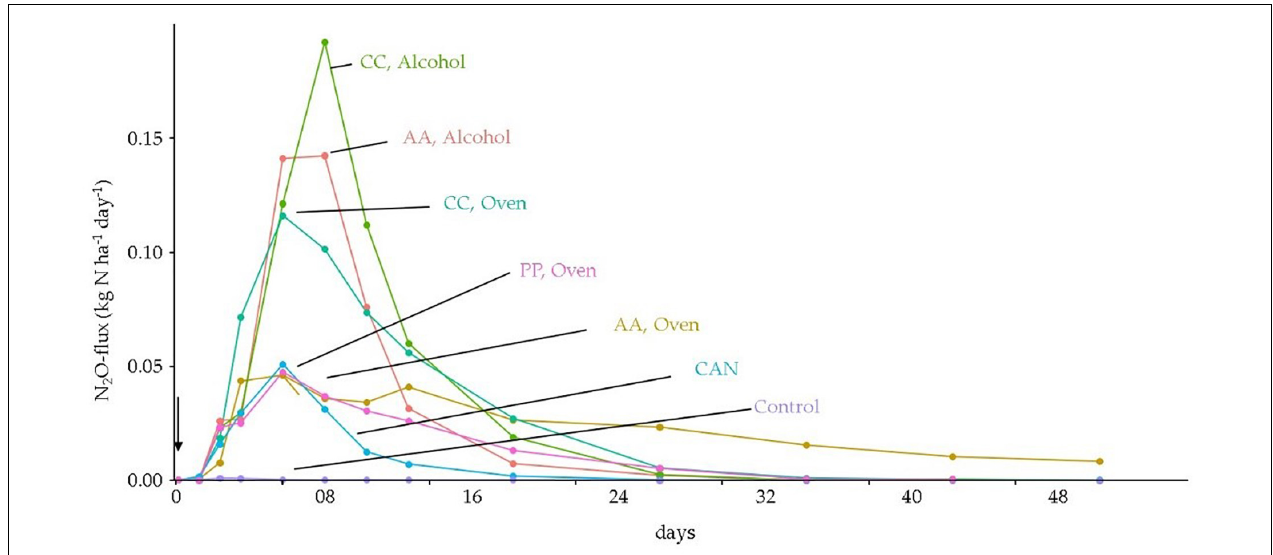
FIGURE 3 | Daily N 2 O fluxes during the 56-day period after soil application of jellyfish differing in species [ A. aurita (AA), C. capillata (CC), P. periphylla (PP)] and pre-treatment (oven-dried and alcohol-dried). The arrow indicates the fertilizer application event. Mean values are shown ( n = 5).